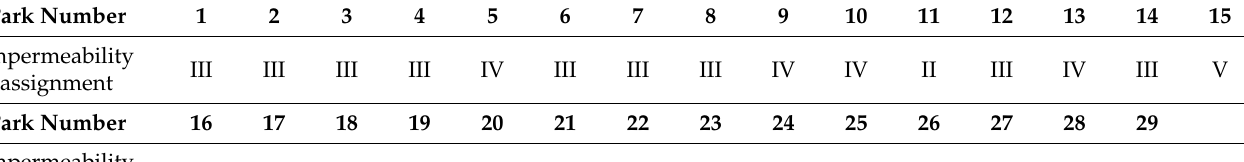
Table 14. The assignment results of the impermeability of country parks.